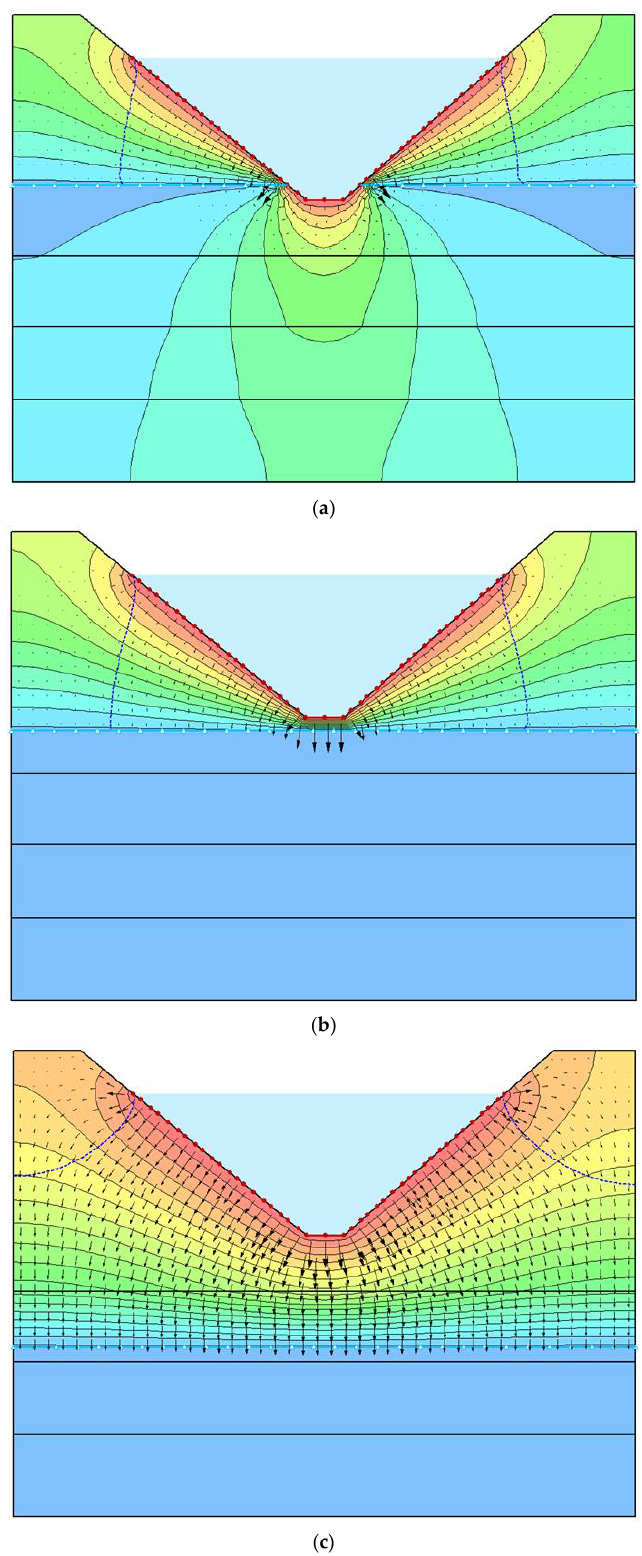
Figure 17. Streamline directions and piezometric lines of the reservoir bottom. ( a ) Groundwater level above the reservoir bottom. ( b ) Groundwater level below the reservoir bottom (L = 5 m). ( c ) Groundwater level below the reservoir bottom (L = 40